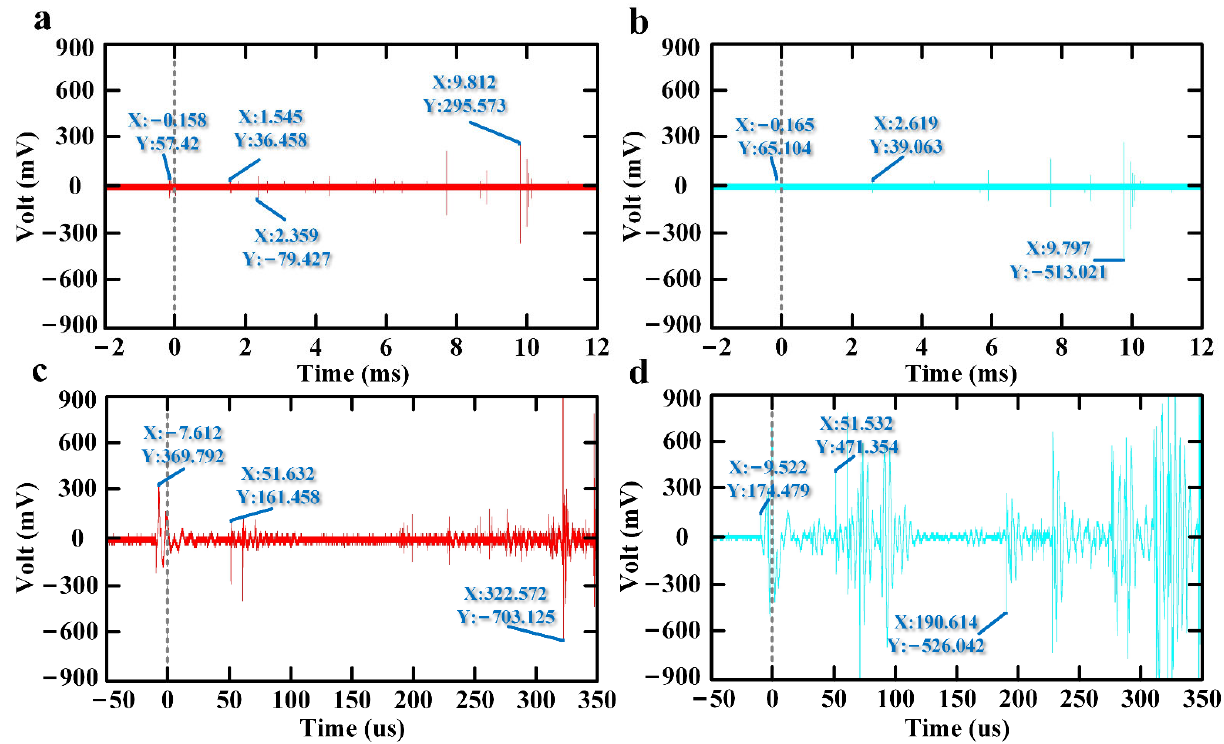
Figure 4. Delay response time of electromagnetic radiation signal of TNT explosion. ( a ) The delay time of electromagnetic signal in test point 1 of 30 kg TNT explosion; ( b ) the delay time of electromagnetic signal in test point 4 of 30 kg TNT explosion; ( c ) the delay time of electromagnetic signal in test point 1 of 60 kg TNT explosion; ( d ) the delay time of electromagnetic signal in test point 4 of 60 kg TNT explosion.